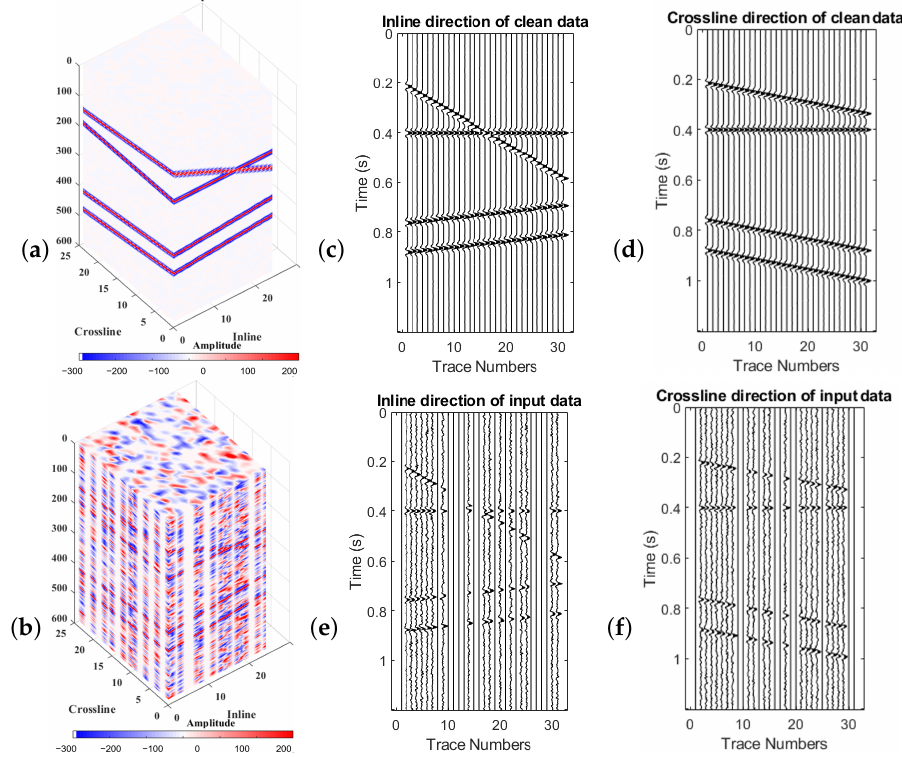
Figure 6. ( a ) Cube of 3-D synthetic clean and complete data; ( b ) Cube of 3-D synthetic data with SNR = 2 and 51% missing traces; ( c , d ) inline and cross-line sections of cube ( a ), respectively; ( e , f ) inline and cross-line sections of cube ( b ), respectively.